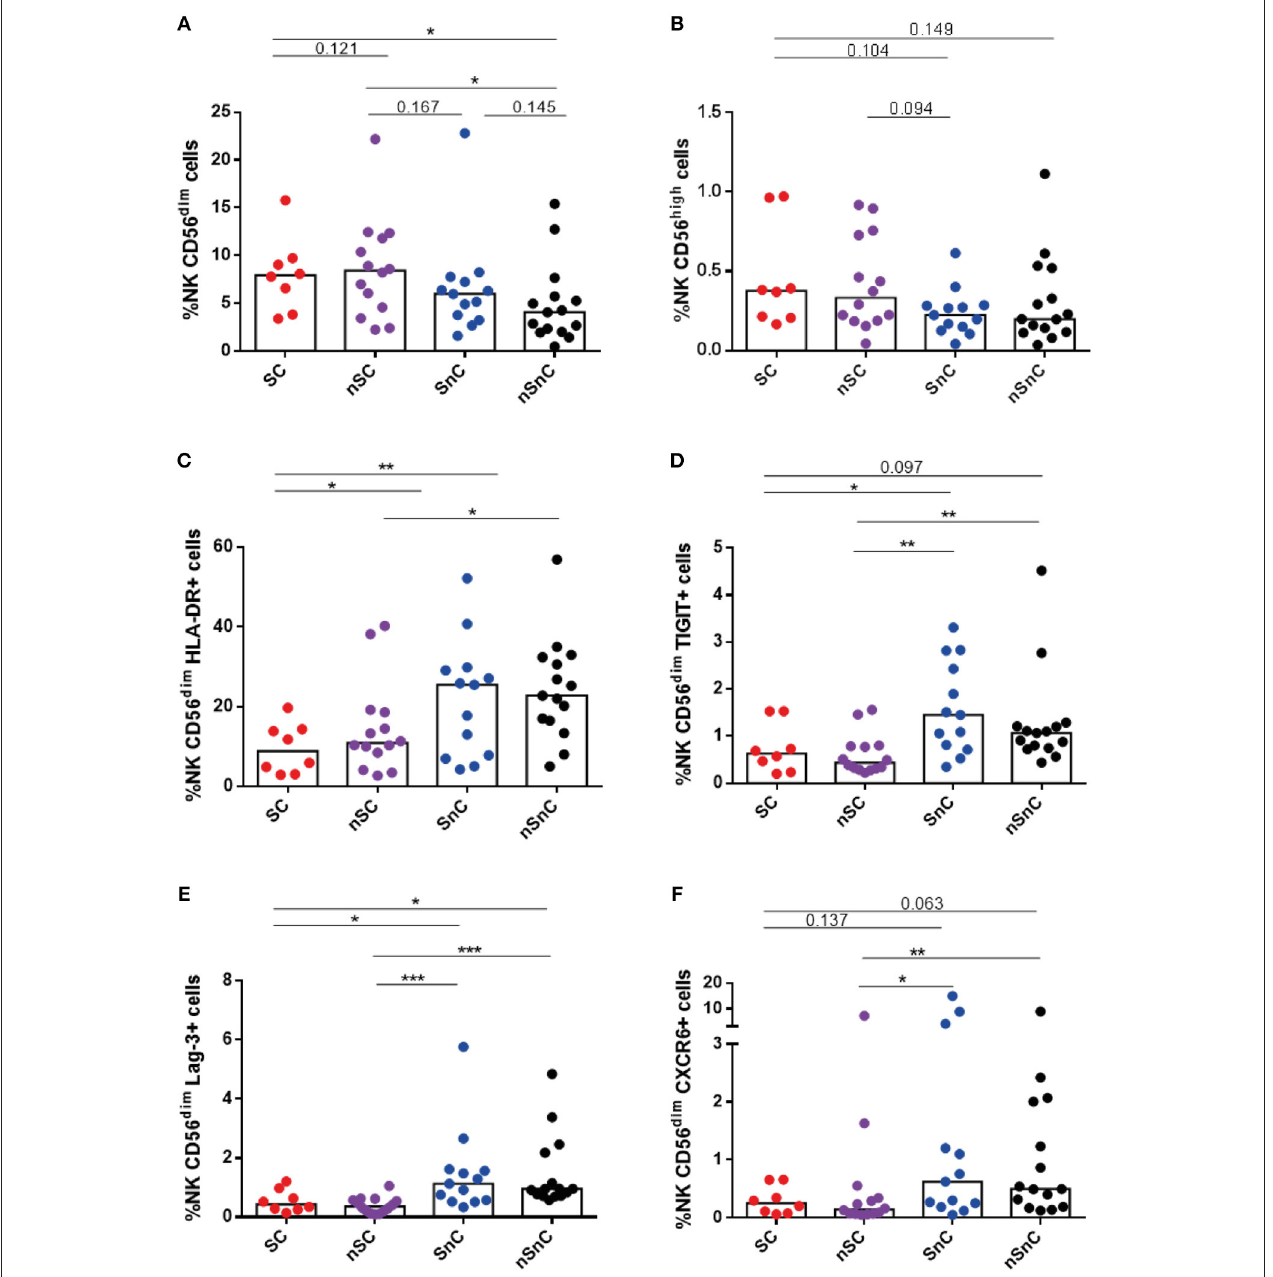
FIGURE 7 | NK cels. (A) NK CD56 dim cells frequency and (B) NK CD56 high cells frequency. (C–E) NK CD56 dim cells expressing HLA-DR, Lag-3 and TIGIT. (F) NK CD56 dim cells expressing CXCR6. SC, supercontrollers, HCV spontaneous clearers and HIV-elite controllers; nSC, non-spontaneously HCV clearers HIV-elite controllers; SnC, HCV spontaneous clearers non-HIV-elite controllers; nSnC, non-spontaneously HCV clearers non-HIV-elite controllers. Mann–Whitney U -tests was used to assess diferencies between groups. Statistical values are shown as: * p = 0.05–0.01; ** p = 0.01–0.001; *** p < 0.001.